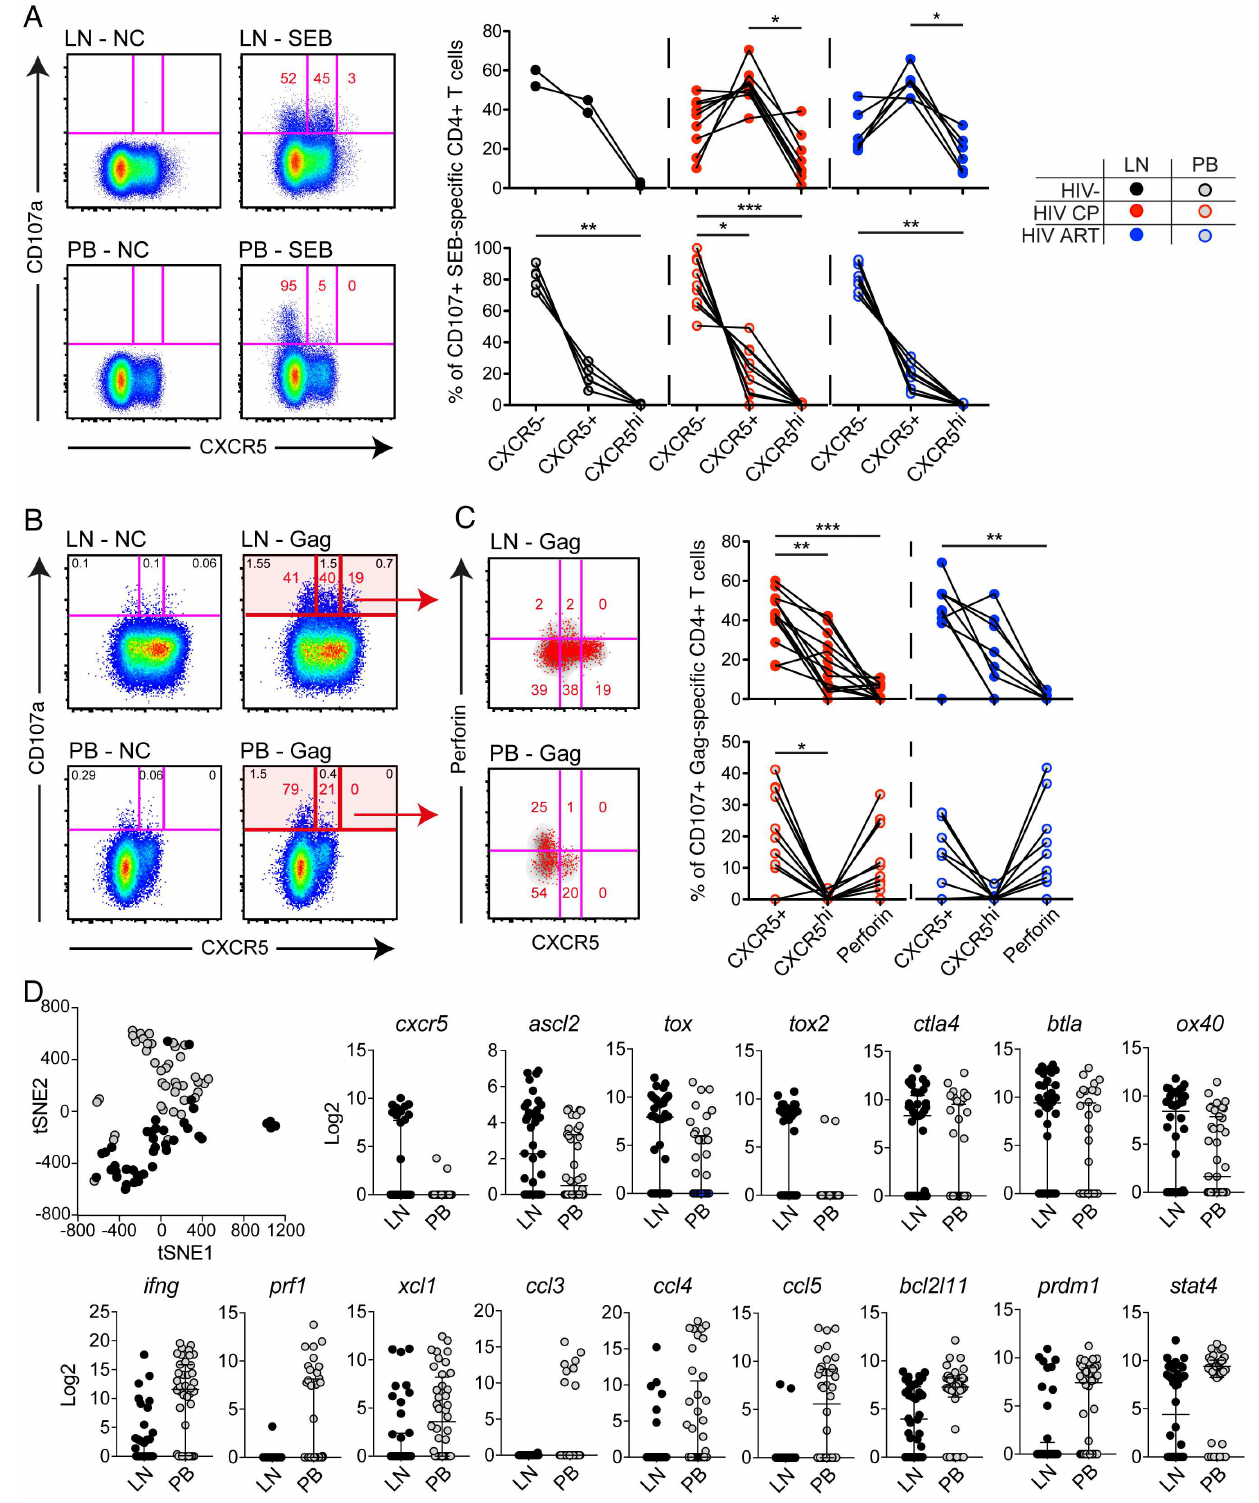
Fig 6. Functional and transcriptional differences between degranulating cells in LN and blood. (A) Flow cytometry plots (HIV-uninfected subject) of matched LN and PB CD107a+ SEB stimulated CD4+ T cell responses. Graphs are showing the frequencies of LN (top) and PB (bottom) CD107a+ SEB stimulated CD4+ T cell responses for CXCR5-, CXCR5+ and CXCR5 hi cells. (B) Flow plots (HIV-infected CP) illustrating the expression of CD107a+